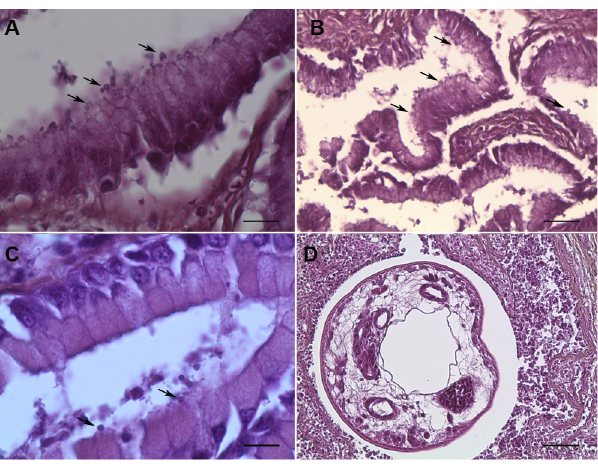
Fig 2. Stained sections of the digestive tract of fish. A. Presence of round bodies suggestive of the developmental stages of C . parvum was observed in the apical position (arrows) within the epithelial cells of gastric glands. Bar = 25 μ m. B. Presence of round bodies suggestive of the developmental stages of C . parvum observed in the apical position (arrows) within the intestinal epithelial cells. Bar = 75 μ m. C. Presence of round bodies suggestive of the developmental stages of C . molnari observed in the apical position (arrows) within the epithelial cells of gastric glands. Bar = 25 μ m. D. Section of a nematode in the intestinal mucosa, surrounded by a severe inflammatory reaction. Bar = 200 μ m. Hematoxylin & Eosin